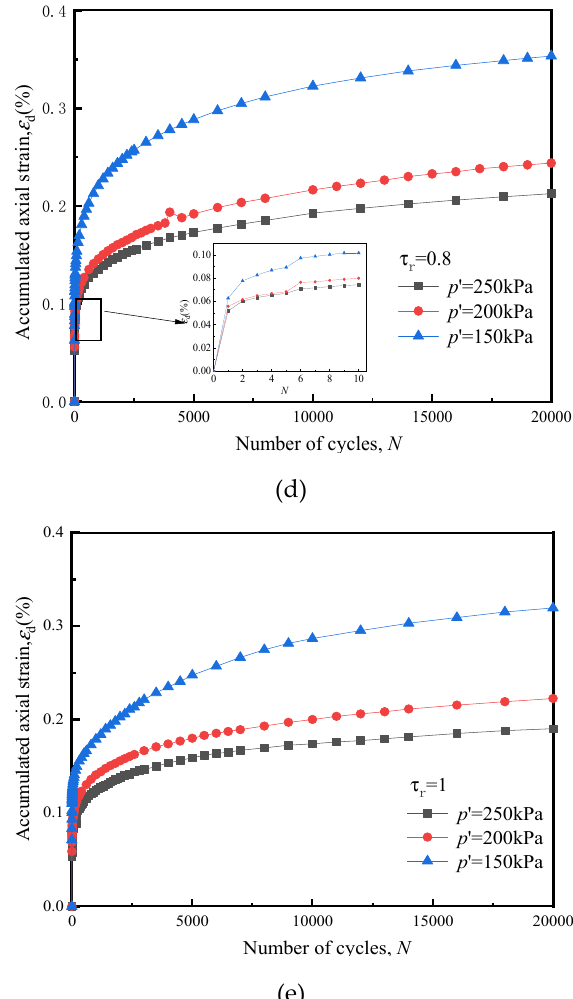
Figure 10. Influence of p ’ on the development of ε d , ( a ) τ r =0, ( b ) τ r =0.2, ( c ) τ r =0.5, ( d ) τ r =0.8, ( e ) τ r =1.